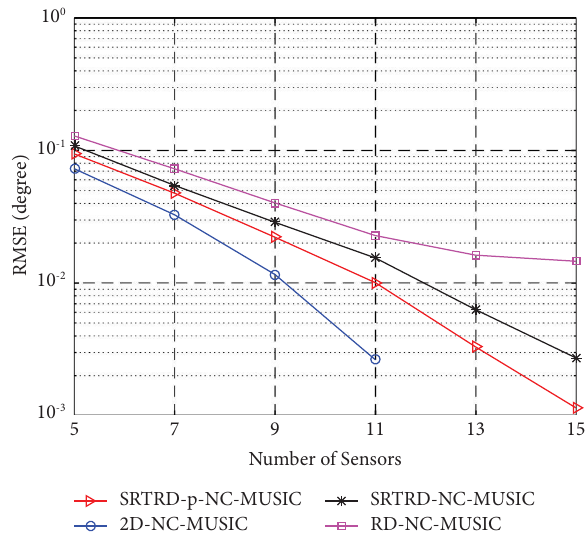
Figure 4: Performance comparison with a diferent number of sensors, SNR � 10dB and L � 500.